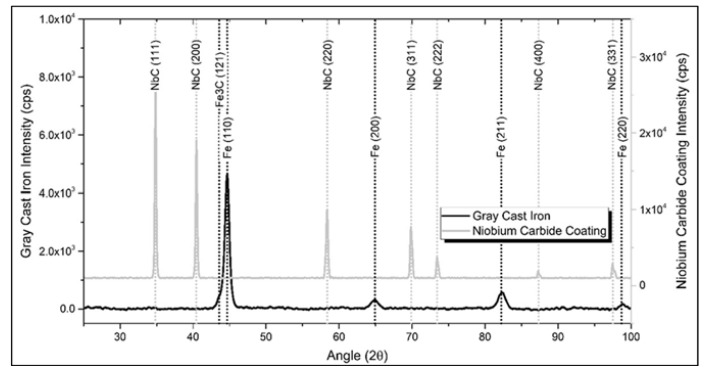
Figure 4. XRD spectrum of gray cast iron and NbC coating for 4 h at 1223 K.